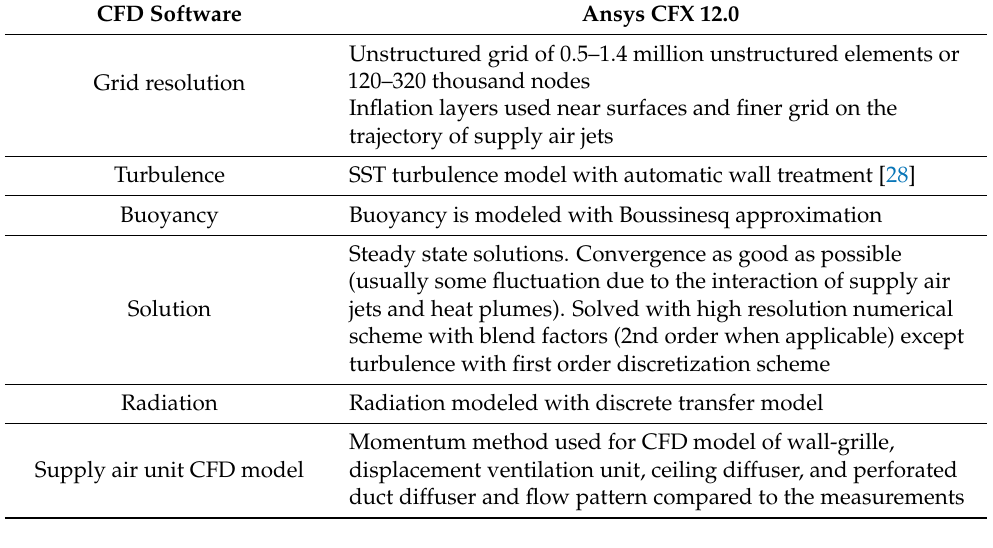
Table 1. Details of CFD-simulation.